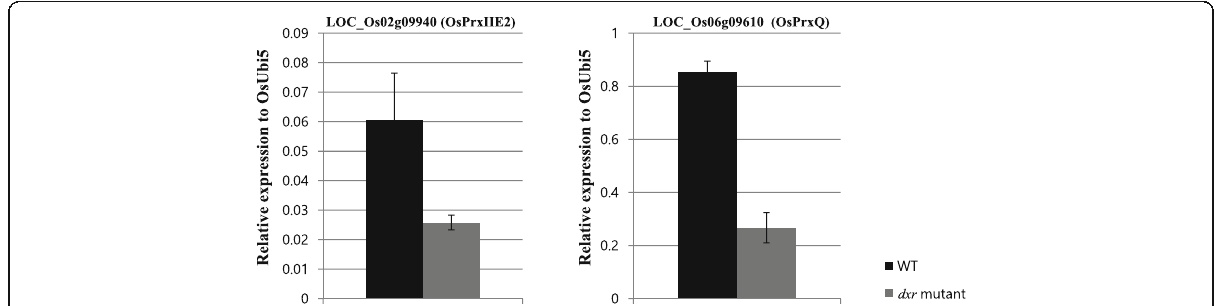
Fig. 5 RT-PCR analysis of OsPrxQ/LOC_Os06g09610 and OsPrxIIE2/LOC_Os02g09940 in dxr mutant. Expression level relative to OsUbi5 was compared between WT segregant and dxr